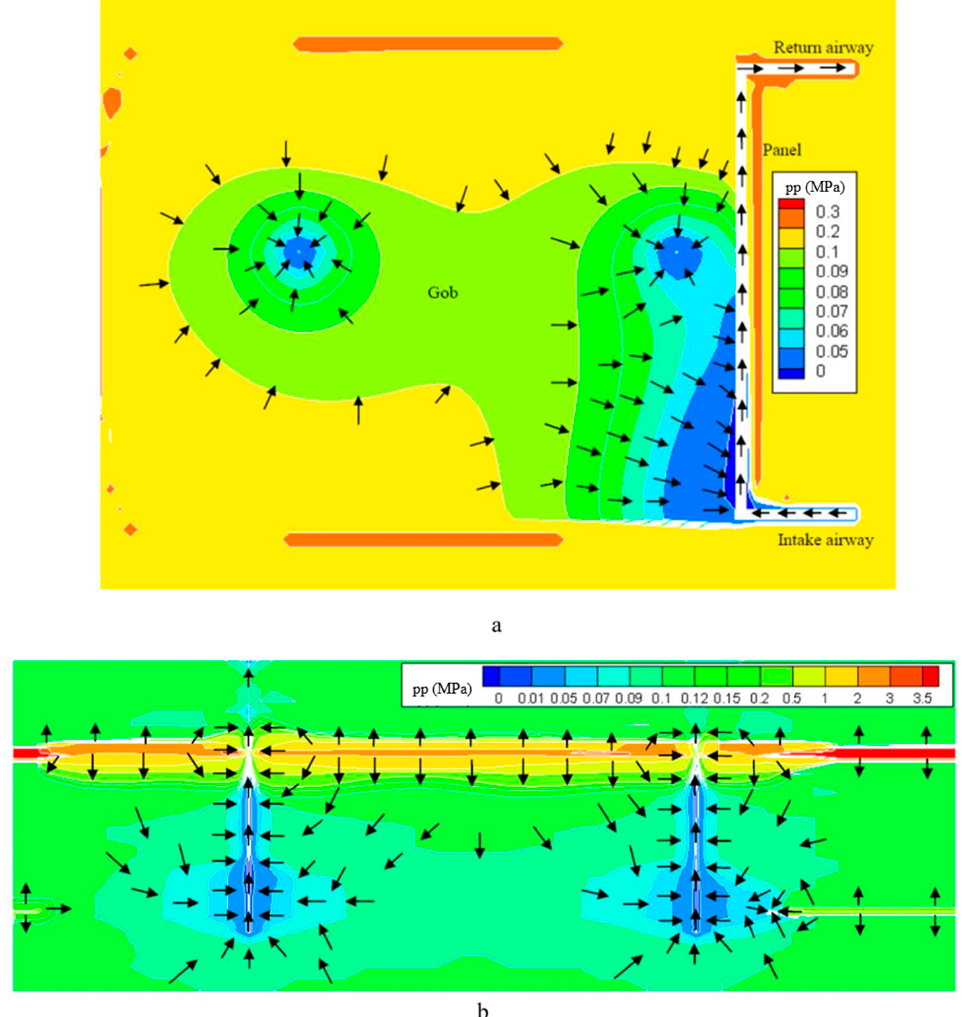
Figure 9. Gas seepage path in the process of extraction. ( a ) Gob section. ( b ) SGV section.